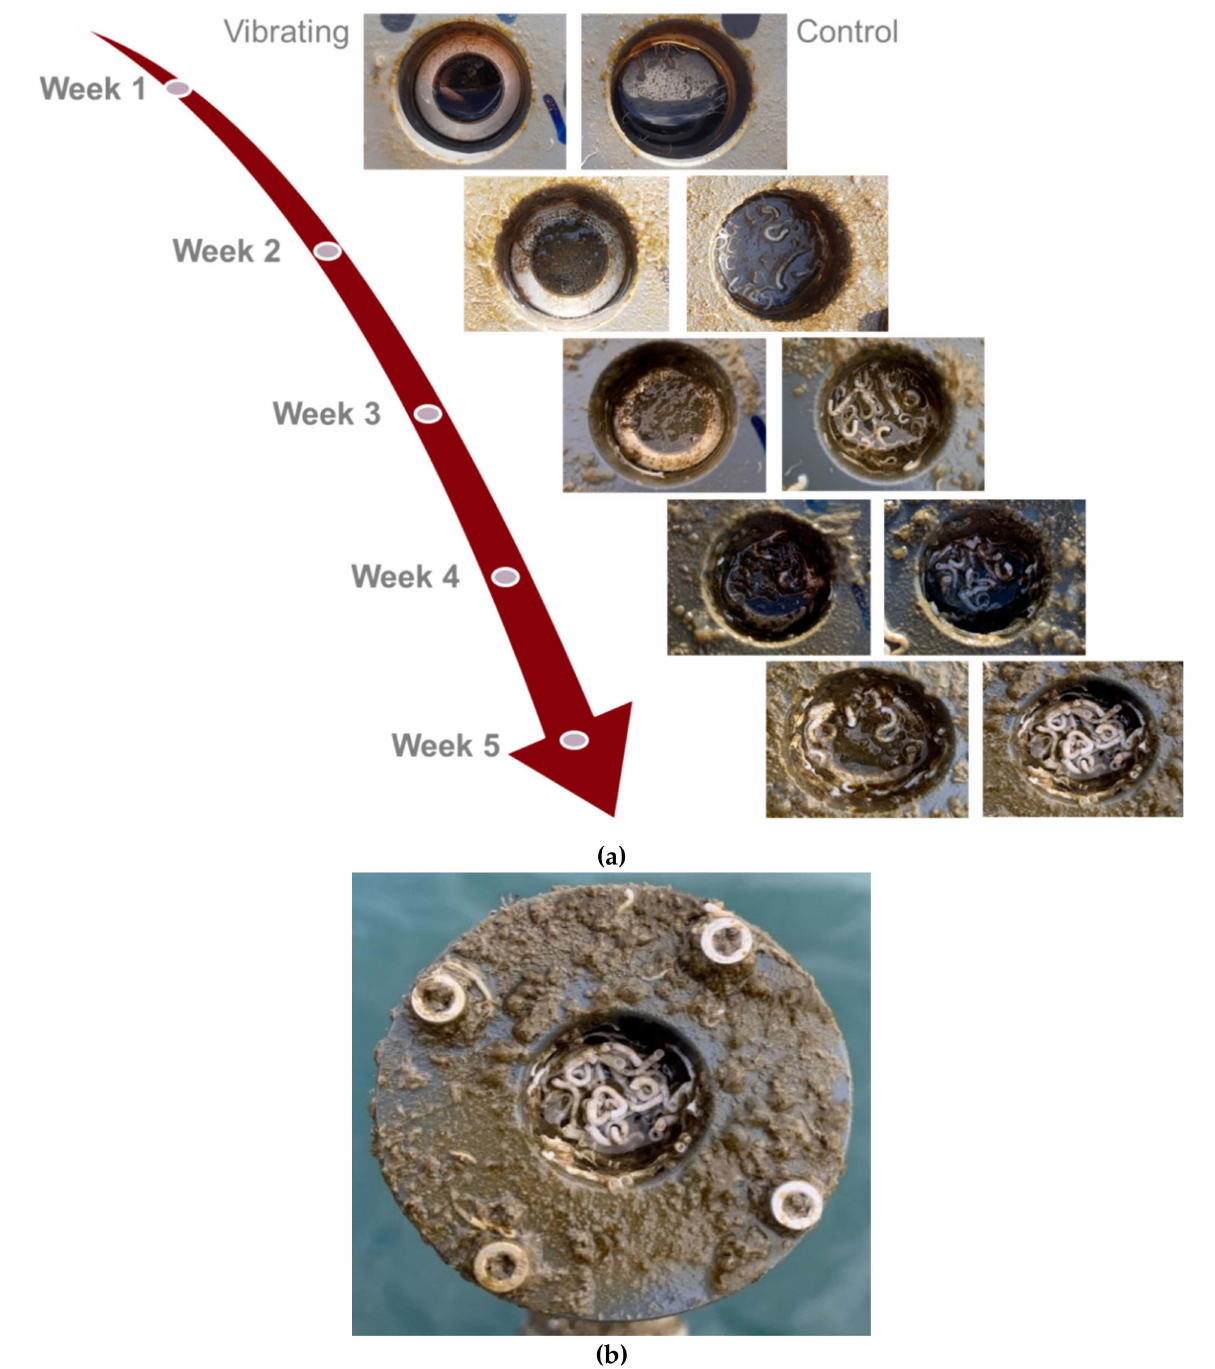
Figure 10. ( a ) Evolution of the biofouling on a vibrating and a control membrane for five weeks; ( b ) zoom on an immersed membrane after five